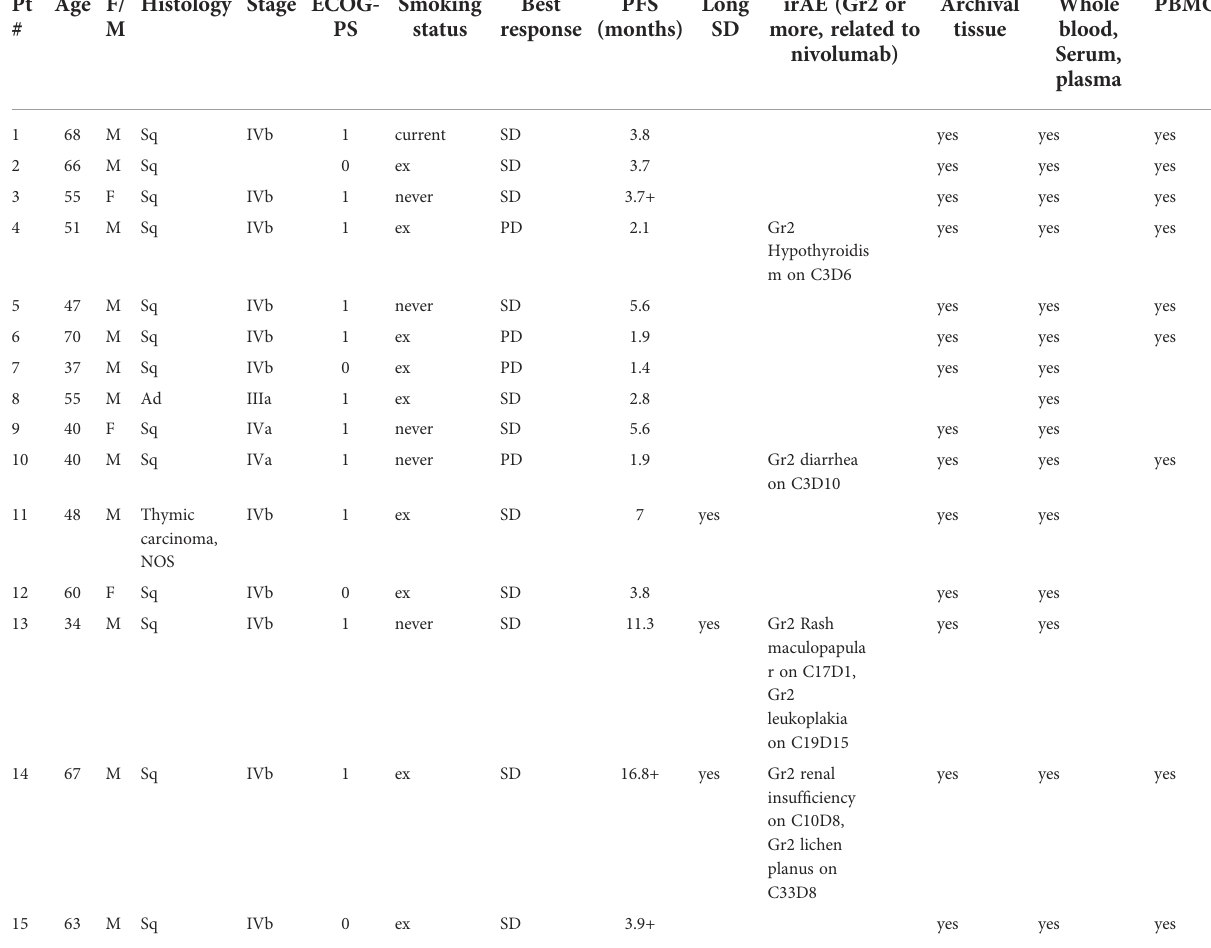
TABLE 1 Patient characteristics and treatment results from the PRIMER study cohort. Pt Age F/ Histology Stage ECOG ‐ # M